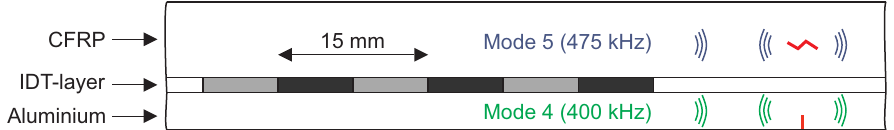
Figure 9. Sketch of an arrangement based on the example considered here for an interdigital SHM system for a composite pressure vessel